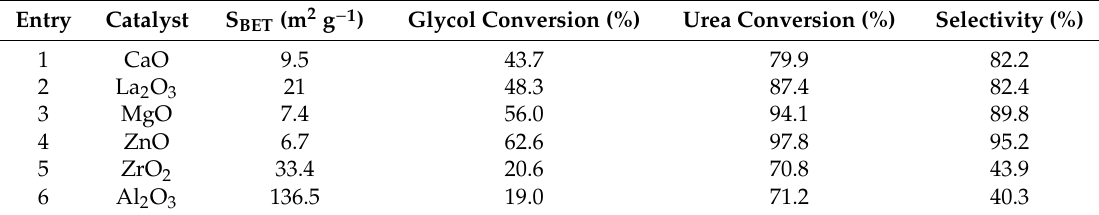
their surface area Table 1. Catalytic performance of metal oxides in the synthesis of ethylene carbonate, as a function of their surface area [27].